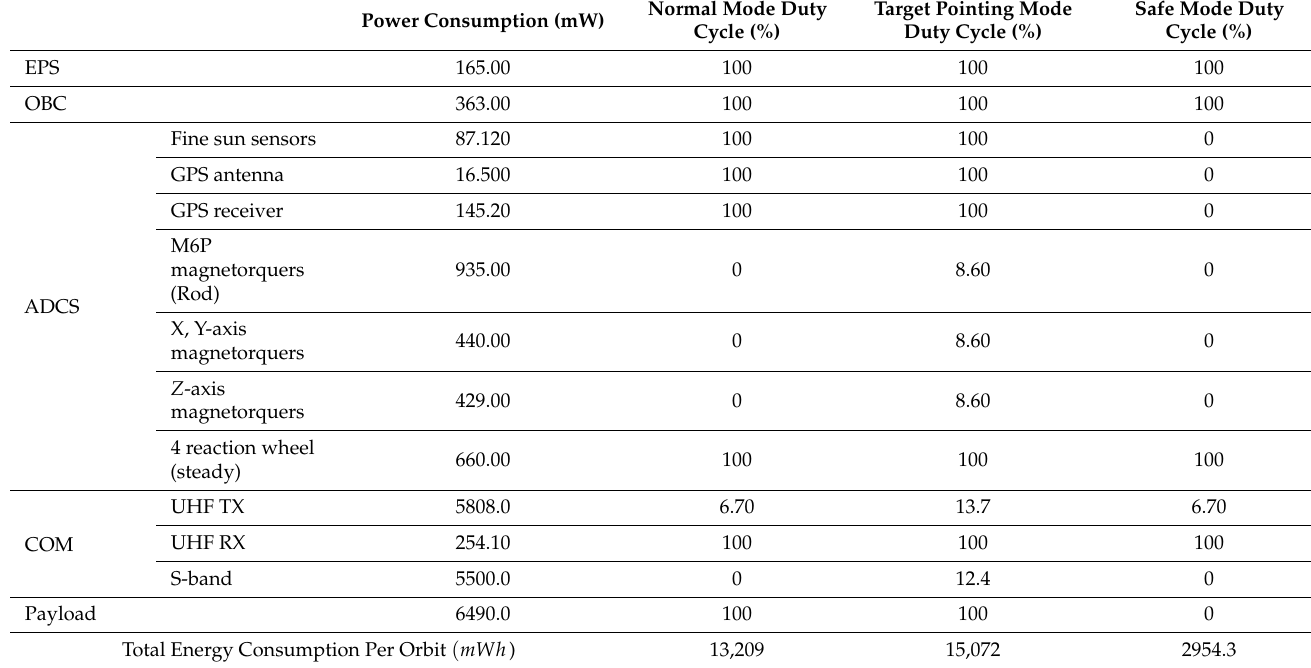
Table 4. Power consumption of Light-1 during different